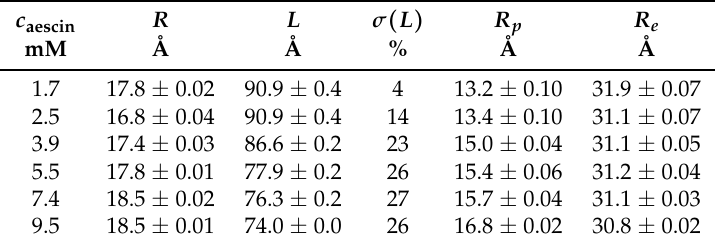
Table 2. Fit parameters from the cylinder at 10 ◦ C and ellipsoid fit at 40 ◦ C. R and L are the radius and length of the cylinder. σ ( L ) is the polydispersity of L . R e and R p are the equatorial and the polar radius of the ellipsoid, respectively. c aescin R σ ( L